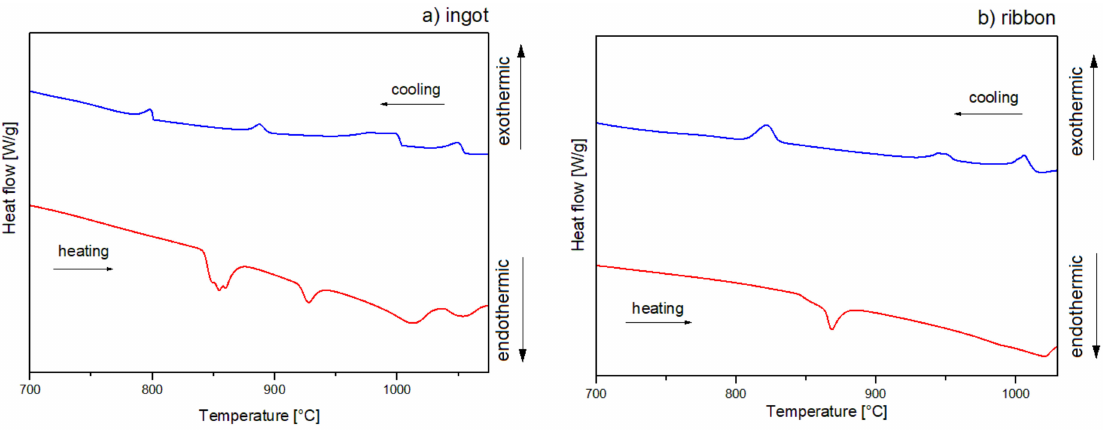
Figure 7. DSC curves of Al 65 Cu 20 Fe 15 alloy for ( a ) ingot, ( b ) ribbon, 20 ◦ /min. Table 2. Phases identified based on XRD patterns with DSC